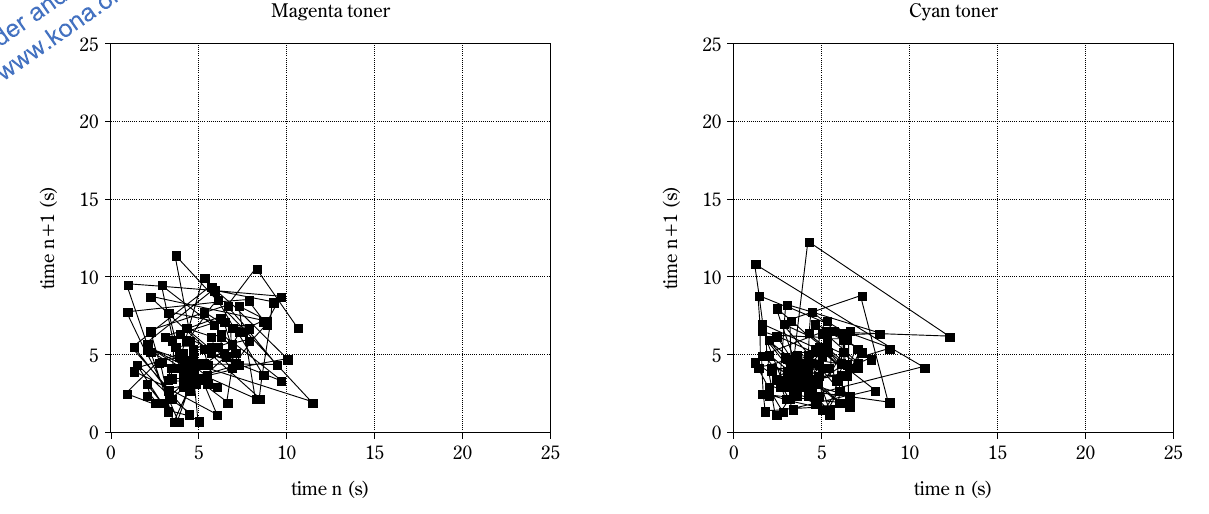
Fig. 15 Delay map for two samples of different color (magenta and cyan) of the commercial xerographic toner Canon CLC700. The points of time T n at which an avalanche occurs are represented against the points of time T n (cid:3) 1 of the next avalanche.